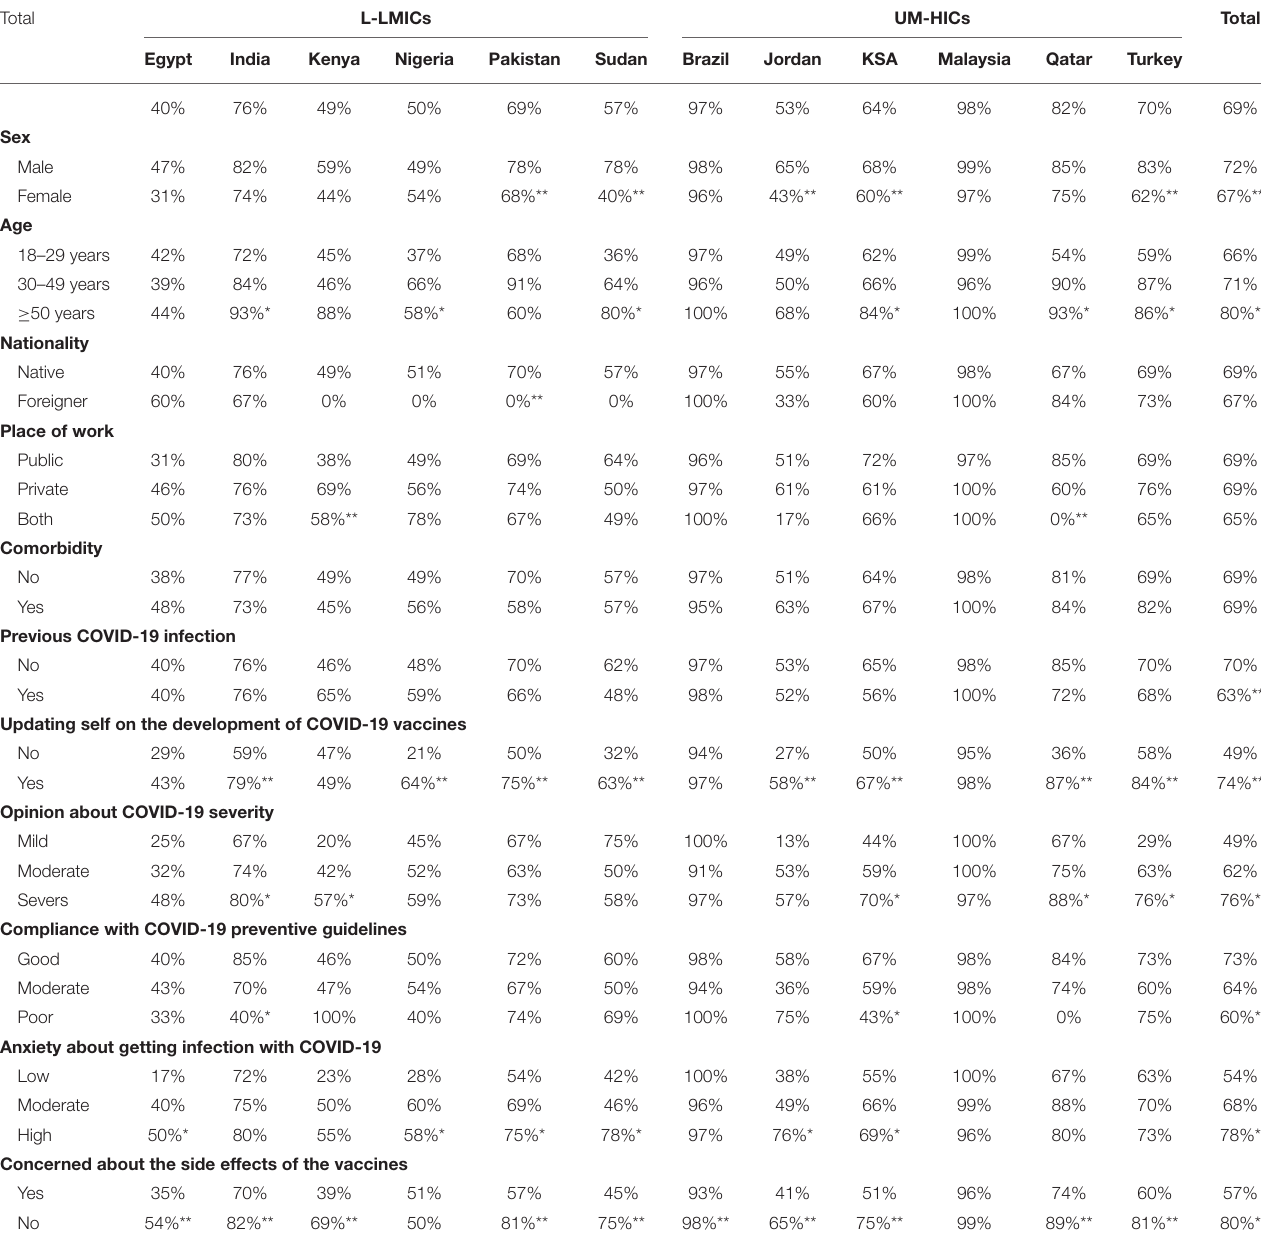
TABLE 4 | Agreement among HCWs in different countries to accept a COVID-19 vaccine - Data are presented as